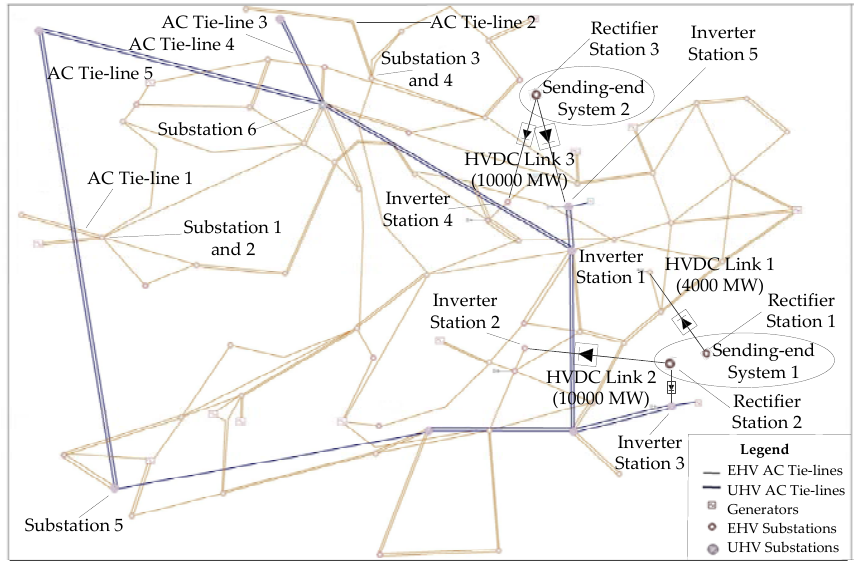
Figure 3. Topological structure diagram of provincial power system.